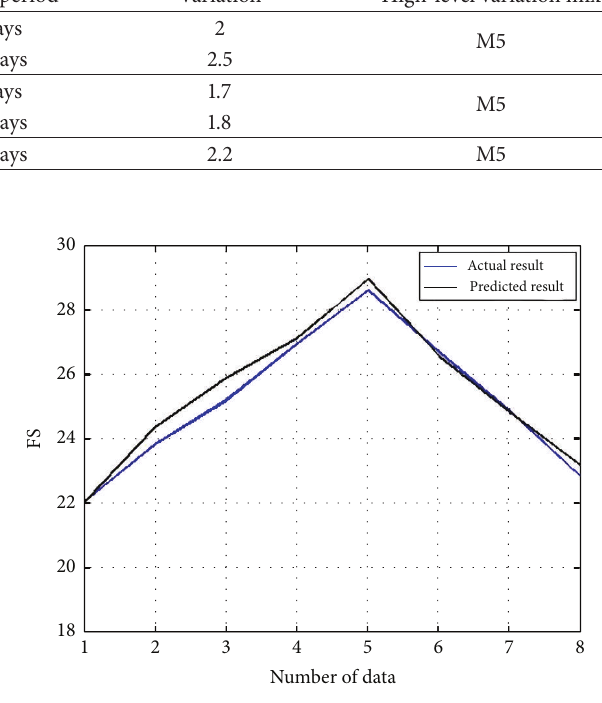
Figure 8: Prediction of compressive strength.